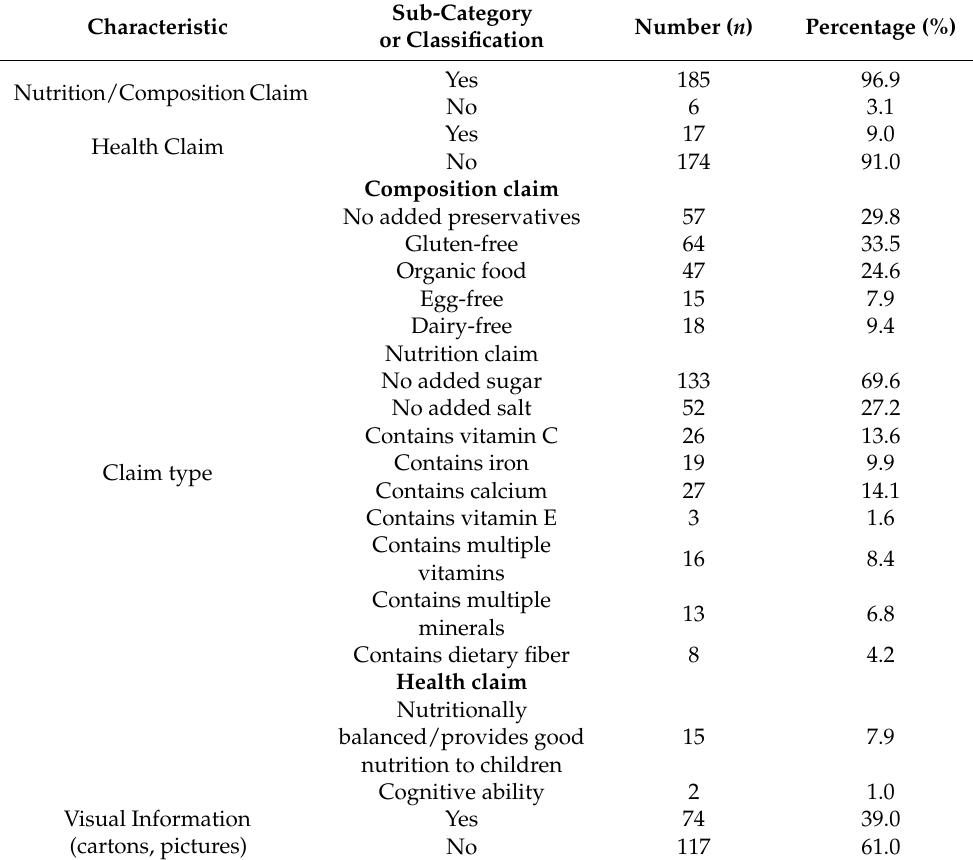
Table 3. Distribution of claim type and visual information for CACFs considered in the present study.